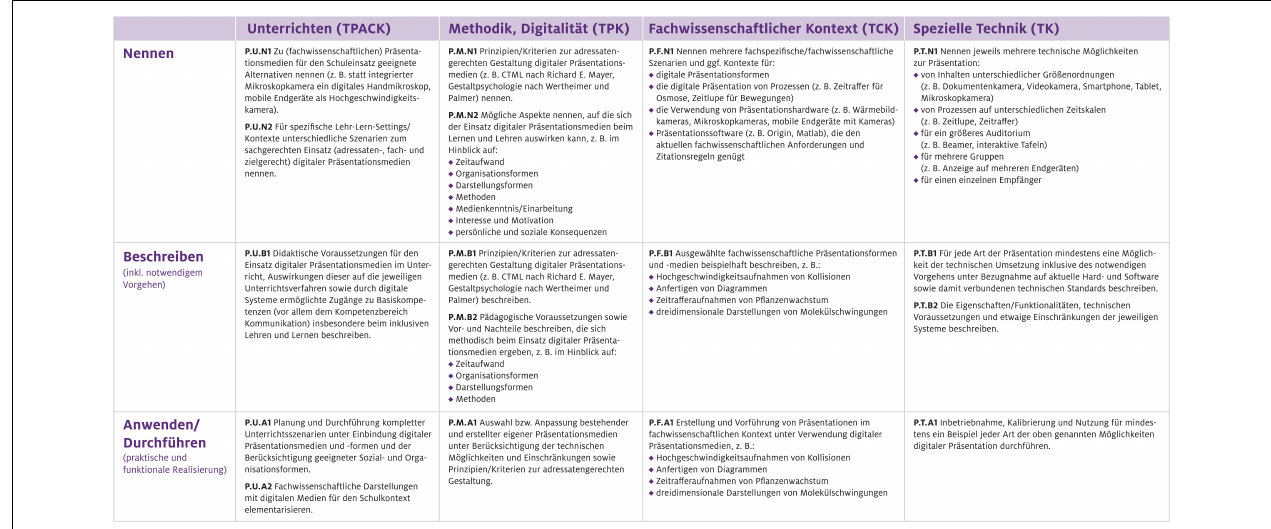
FIGURE 4 | Excerpt from the collaborative online board, with the instructional material for reviewing the competency expectations. Here in case of the competence area Presentation [modified from Becker et al. (2020); English translation in Kotzebue et al.